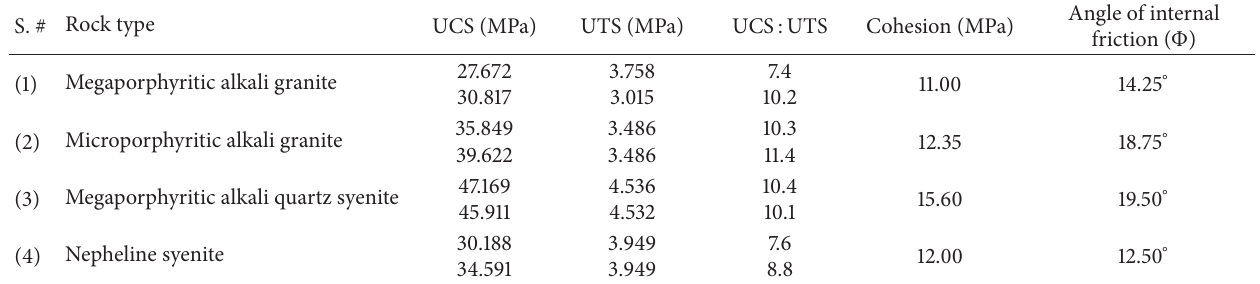
Table 1: UCS, UTS, and shear strength of the studied